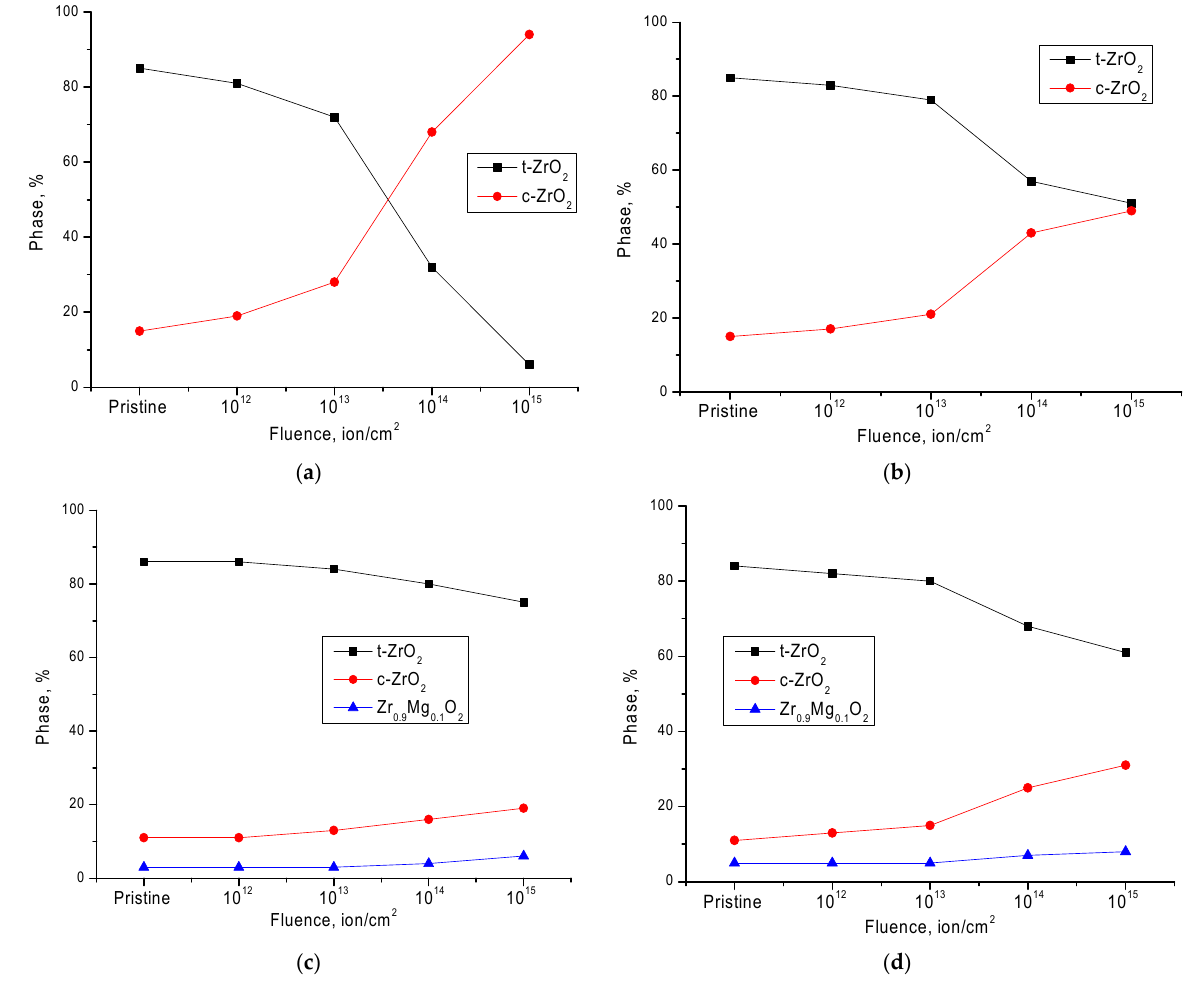
Figure 3. Diagrams of phase polymorphic transformations in ceramics as a result of irradiation with heavy ions: ( a ) initial sample; ( b ) doped with 0.05 mol.% MgO; ( c ) doped with 0.10 mol.% MgO; ( d ) doped with 0.15 mol.% MgO.